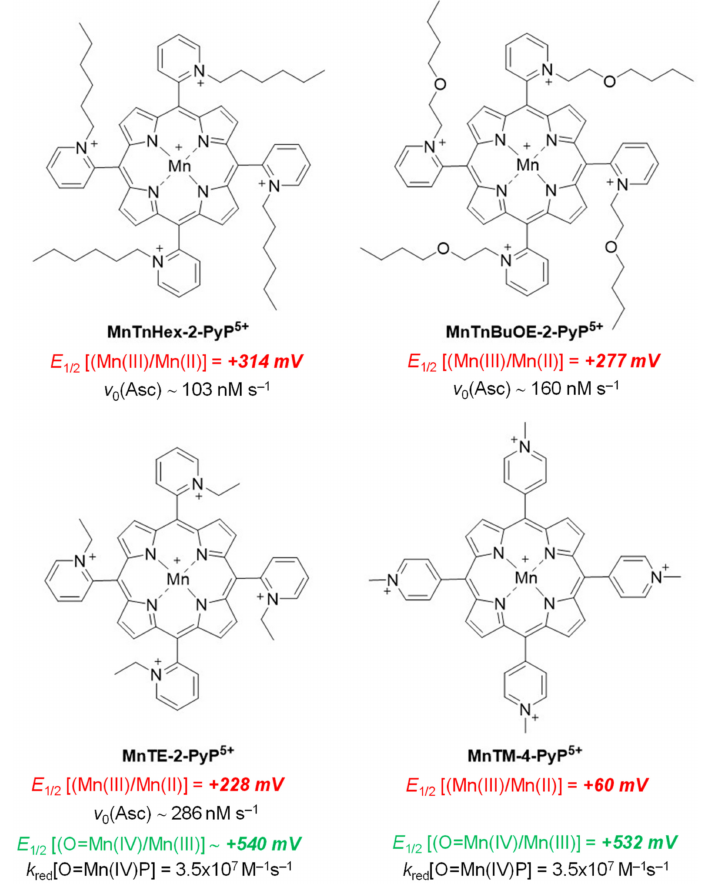
Figure 1. Chemical structures of redox-active cationic Mn(III) porphyrins and the reduction po- tentials, E 1/2 vs. NHE for Mn III /Mn II (in red) and O = Mn IV /Mn III (in green, measured at pH 11) redox couples [6,7]. The values shown for the k red and E 1/2 [(O = Mn(IV)/Mn(III)] for the ortho